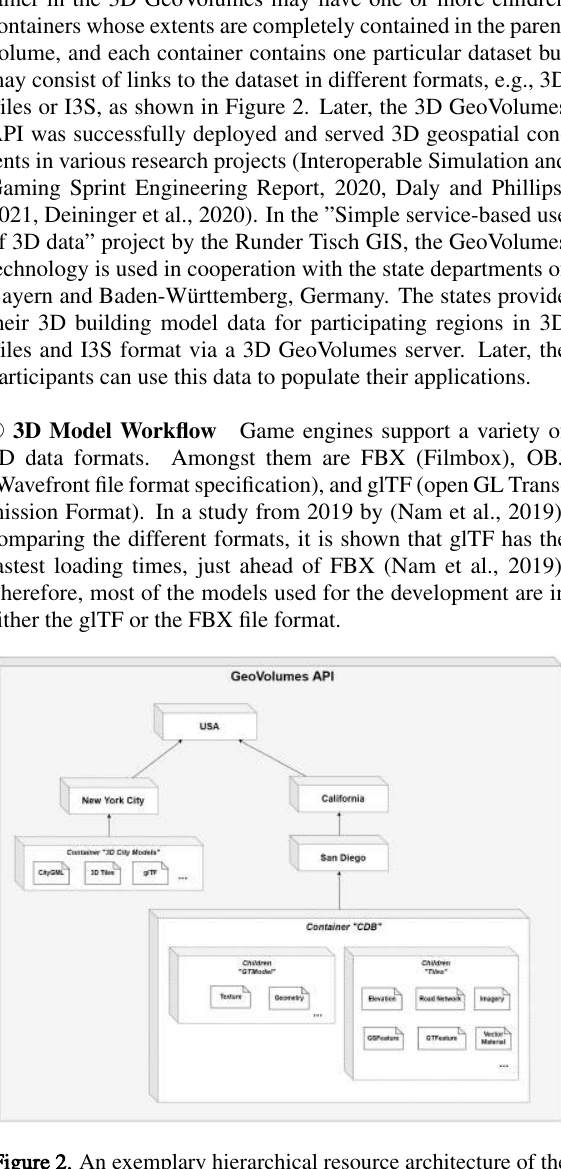
Figure 2. An exemplary hierarchical resource architecture of the 3D GeoVolumes